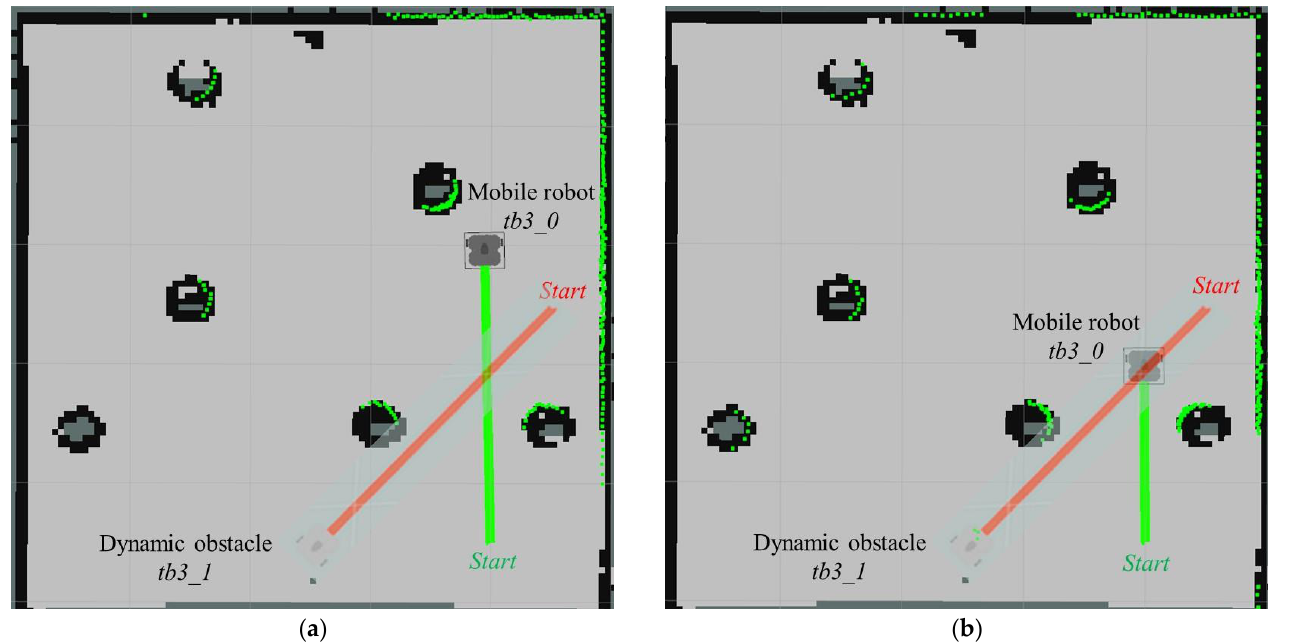
Figure 18. ( a ) Rviz simulation for dynamic environment scenario 3 after testing the LSTM model with goal point of (4.0, 3.0) for 𝑡𝑏3_0 , ( b ) Rviz simulation for dynamic environment scenario 3 after testing LSTM model with goal point of (4.0, 2.0) for 𝑡𝑏3_0 .